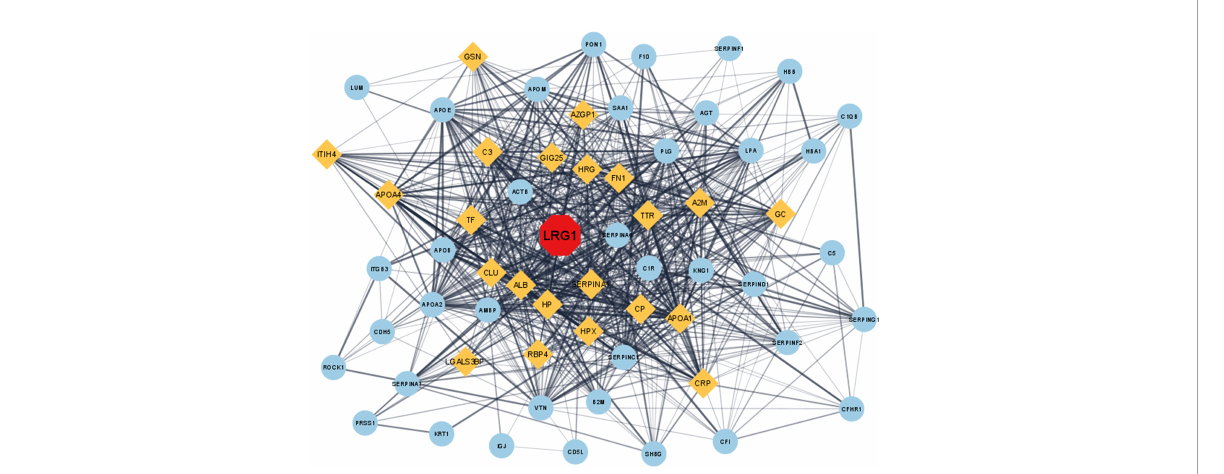
FIGURE 2 In silico study of the DEPs involved in fi brosis-related disease. The proteins were converted to their corresponding gene ID and analyzed using the Cytoscape (3.8.2) online analysis tool. The protein – protein interaction in Cytoscape showed that LRG1 plays a central role in fi brosis ( red ). Closely associated proteins are shown in yellow , while the other distantly related proteins are shown as sky blue . LRG1 , leucine-rich alpha-2 glycoprotein; DEPs , differentially expressed